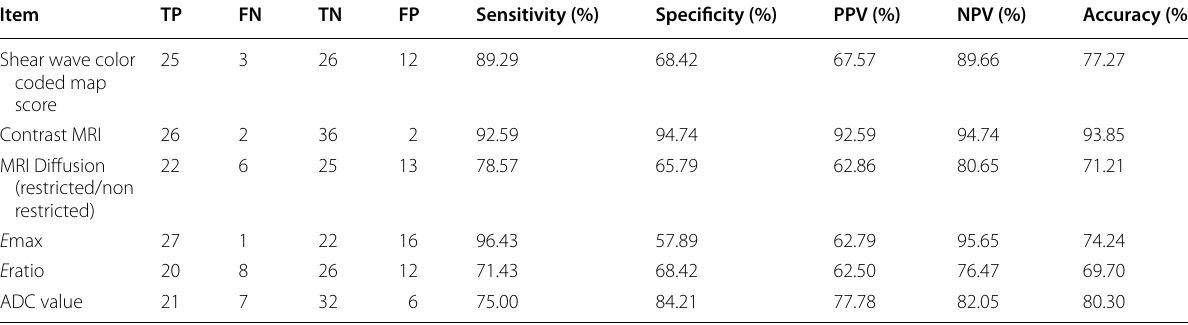
Table 7 Diagnostic performance of different modalities included in the study Item